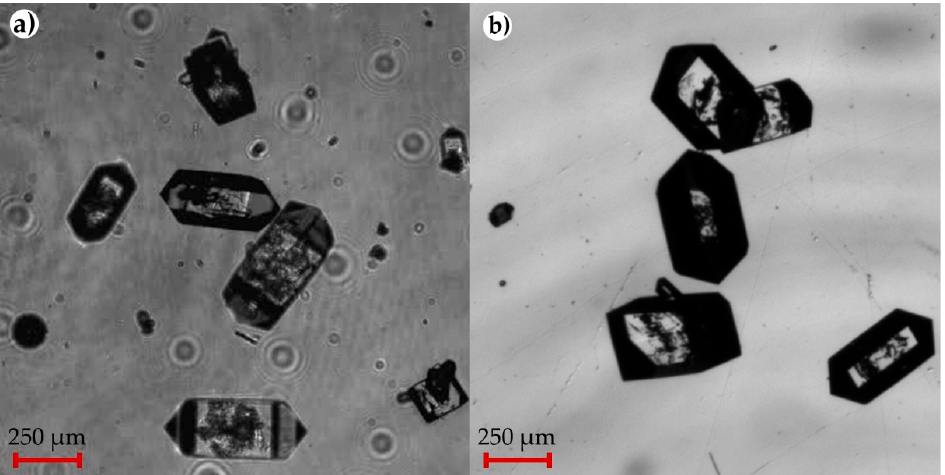
Figure 6. KH 2 PO 4 crystals captured with ( a ) QICPIC (online microscope with bypass); ( b ) shadowgraphic probe (OMOP, inline probe). The images are enlarged for a better view of the edges.